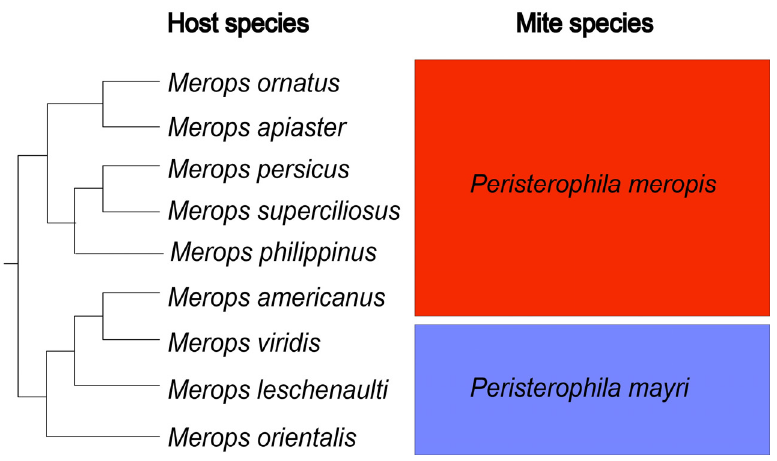
Figure 1. Phylogenetic reconstruction of the bee-eater lineage under study (according to Marks et al. [9]) and associated quill mite species.